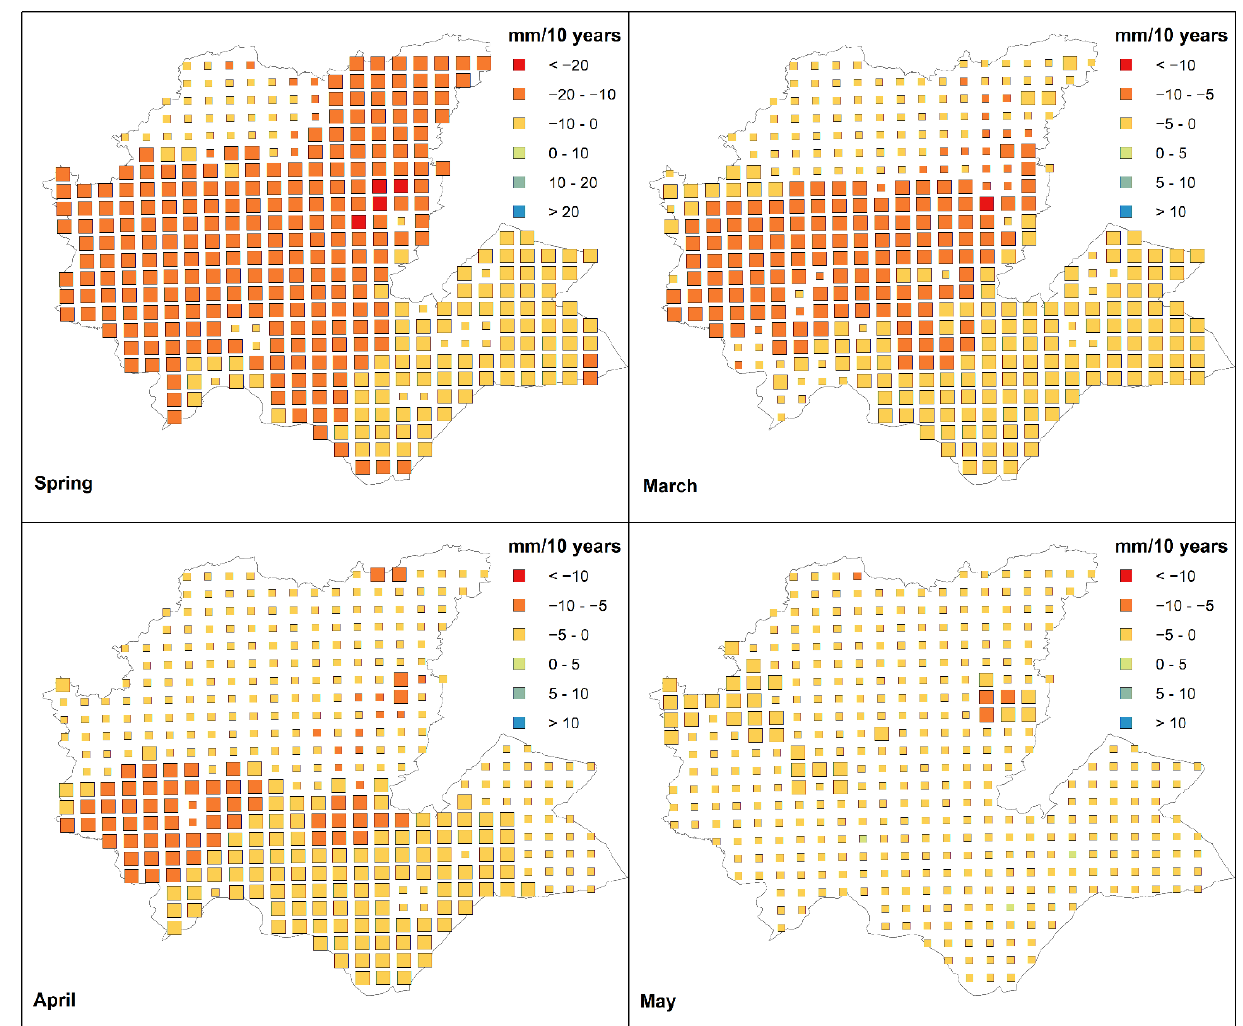
Figure 7. Theil – Sen estimator and MK test for spring season and its constituent months expressed in mm per decade. Squares ’ dimensions indicate the 95% significance level of the trend: large squares: p < 0.05, small squares otherwise.